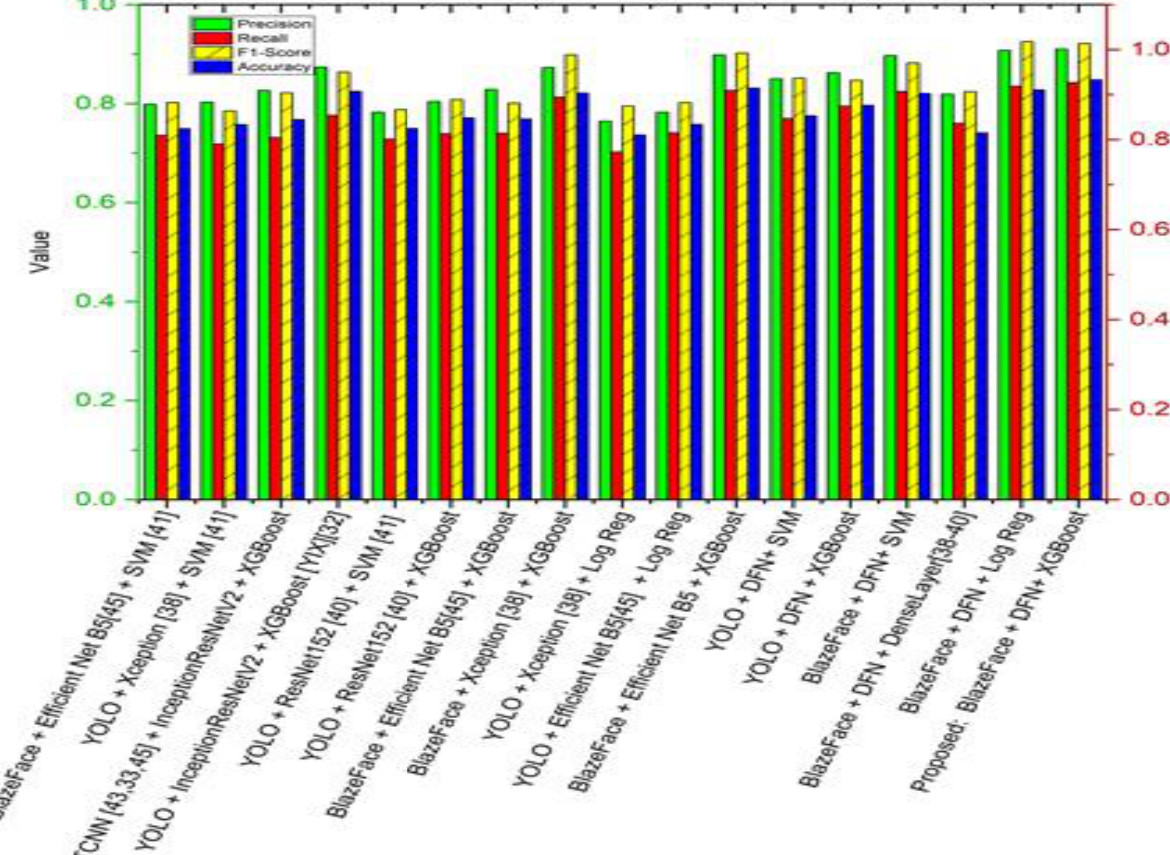
Figure 11. Performance measures comparison Xception and Efficient Net models with the proposed model [17,39].